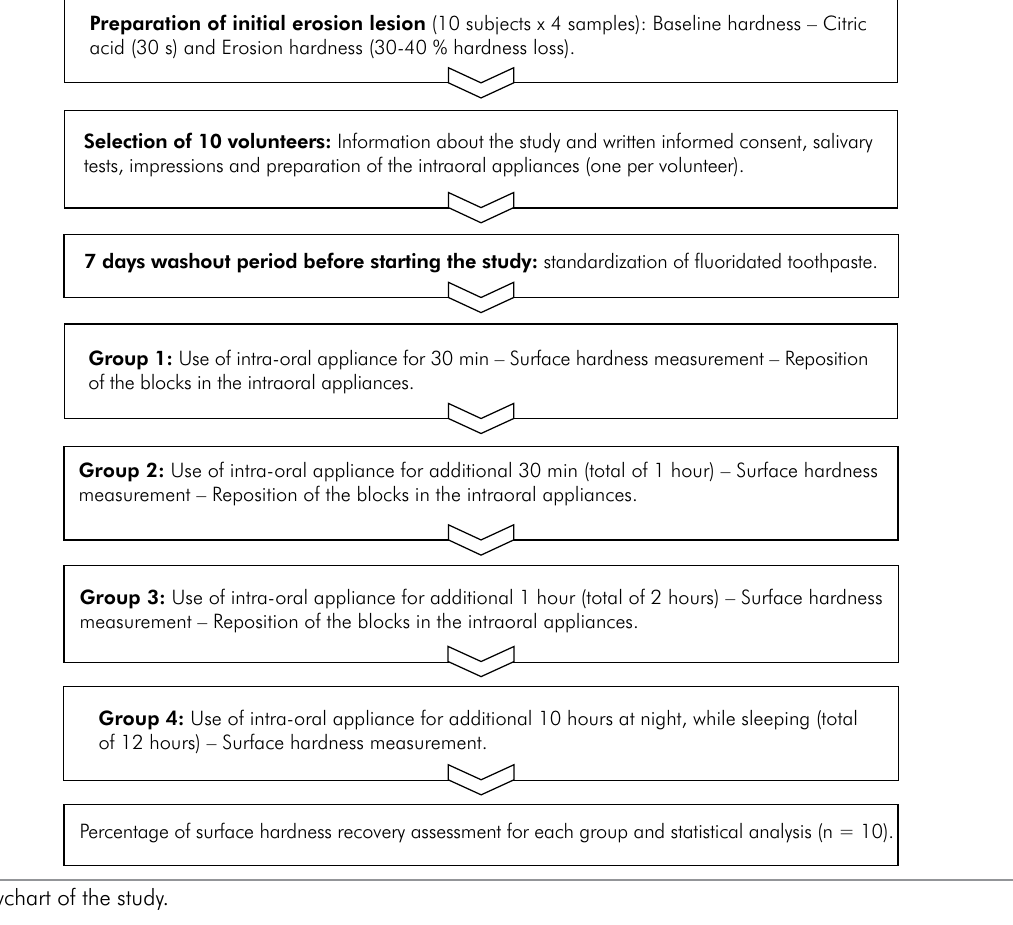
Figure. Flowchart of the